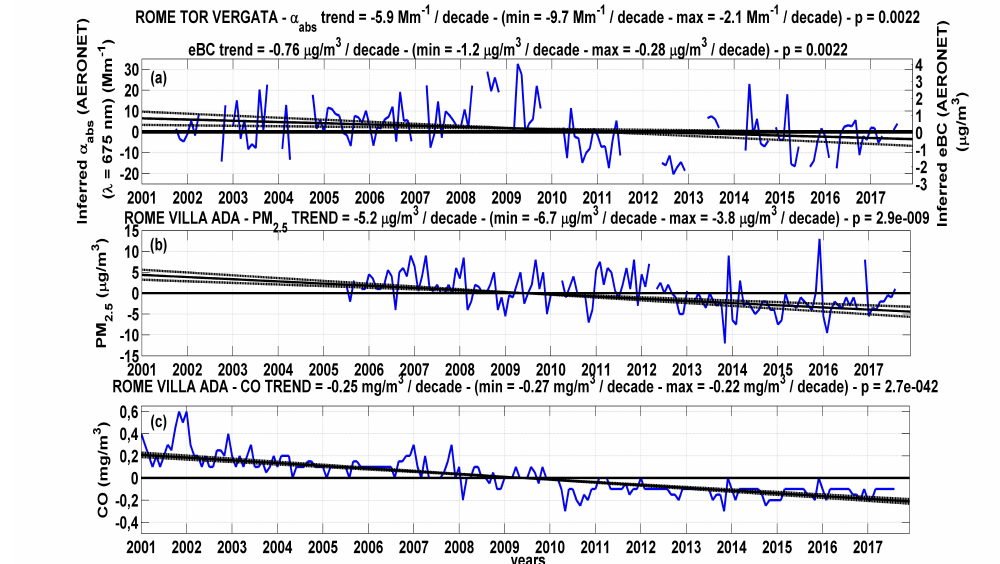
Figure 6. Trend analysis of: ( a ) surface α abs (and surface eBC mass concentration ( µ g/m 3 )) inferred from AERONET data at the site of Rome Tor Vergata, ( b ) PM 2.5 ( µ g/m 3 ) and ( c ) CO concentrations (mg/m 3 ) measured at the site of Rome Villa Ada, from January 2001 to August 2017, using the Mann-Kendall test associated with Sen’s slope. The solid black lines in the test result show the linear trend and the 90% confidence interval of the estimated Sen’s